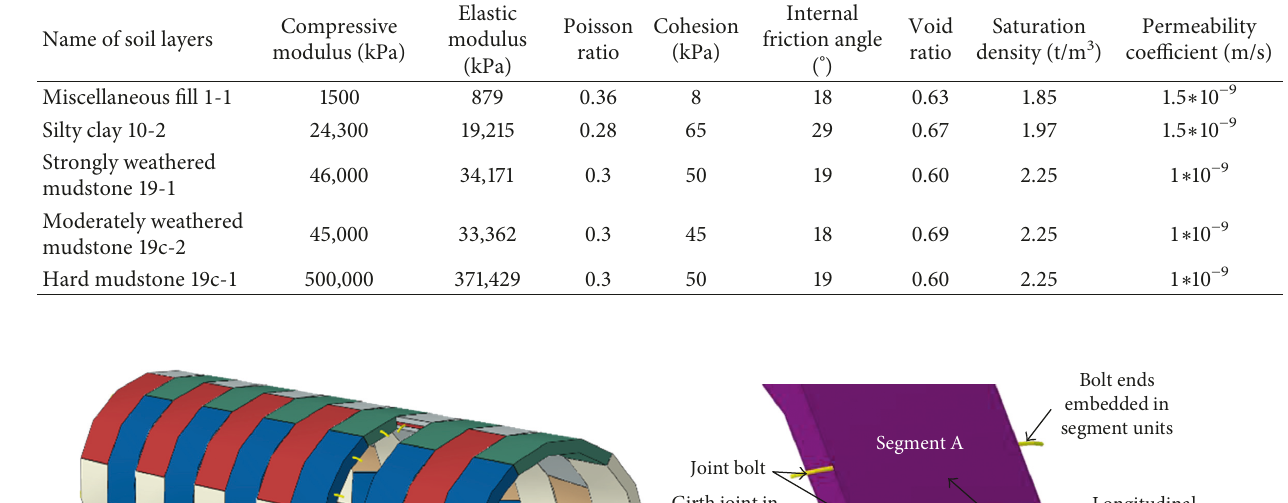
Table 1: Basic parameters of soil mass.